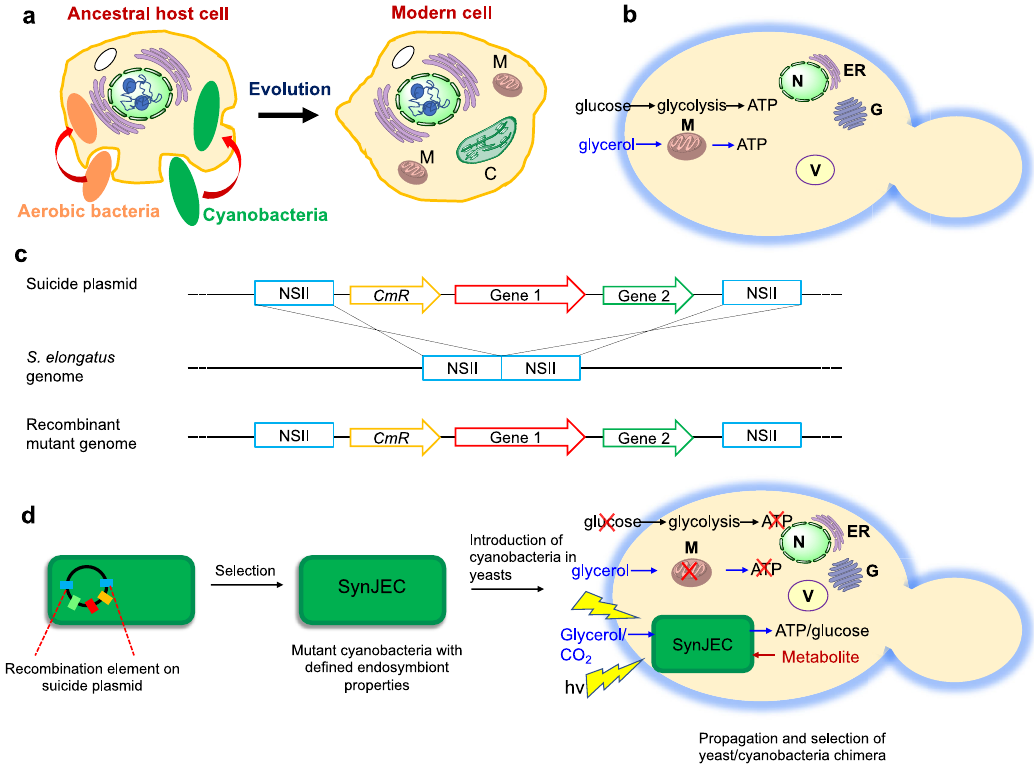
Fig. 1 Endosymbiotic theory and our platform to recapitulate the evolution of photosynthetic eukaryotic cells. a The endosymbiotic theory – Mitochondria, M, are proposed to have evolved from a class of α -proteobacteria while the chloroplast, C, is proposed to have originated from cyanobacteria. Golgi apparatus — G, Endoplasmic reticulum — ER, Vacuole — V. b S. cerevisiae (budding yeast) cells produce ATP by glycolysis or mediated oxidative phosphorylation. c Suicide plasmid-based strategy used in this manuscript to engineer cyanobacterial mutants, SynJEC strains. d Our platform: We use suicide plasmid-based strategy to engineer cyanobacterial endosymbionts, SynJEC strains, such that they perform chloroplast-like functions. S. cerevisiae mutants, de fi cient in ATP synthesis by oxidative phosphorylation under de fi ned photosynthetic selection conditions, are used as host strains. Engineered cyanobacteria strains, SynJEC, are then introduced into the yeast cells by a cell fusion process that is developed and optimized (see Methods). The yeast/cyanobacterial chimera are selected under de fi ned photosynthetic selection conditions where the cyanobacterial endosymbionts provide ATP to the mutant S. cerevisiae host cells, and S. cerevisiae provide essential metabolites to the S. elongatus